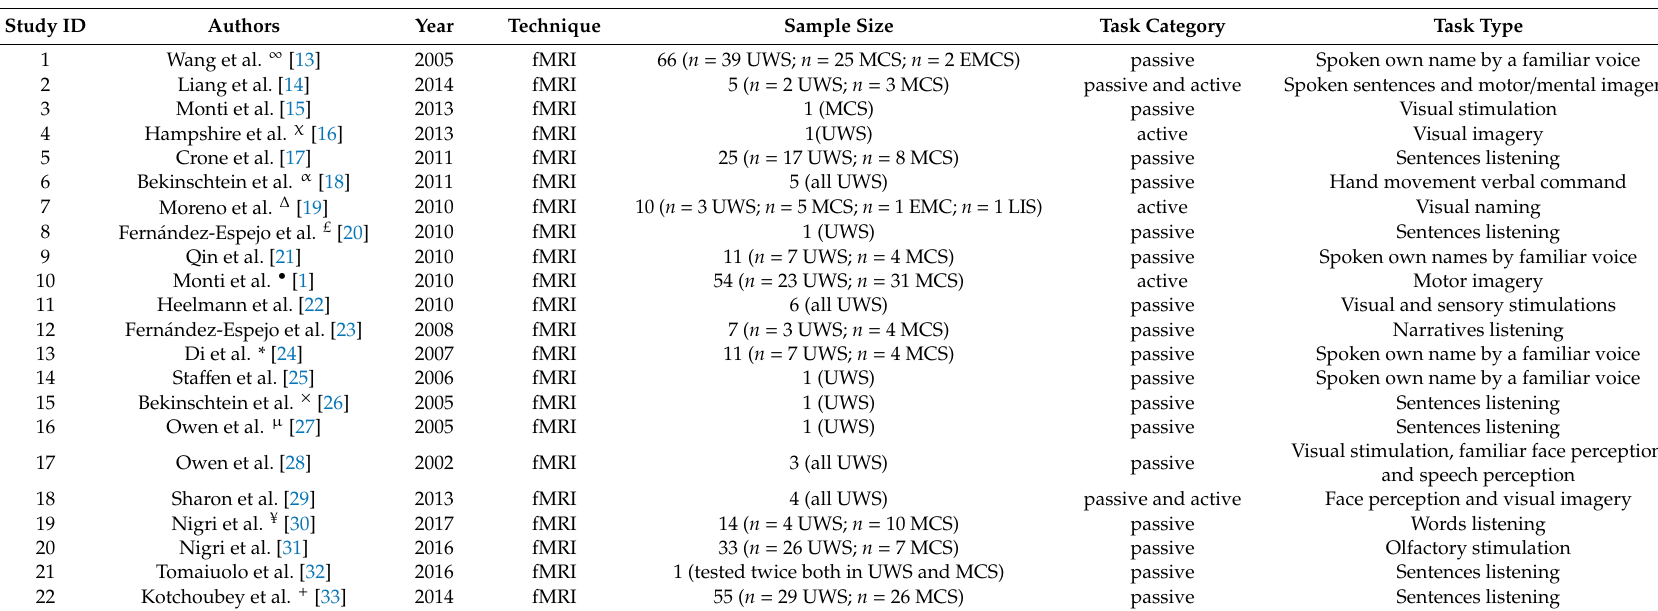
Table 1. Studies included in the meta-analysis. The table shows the main characteristics of the studies included in the